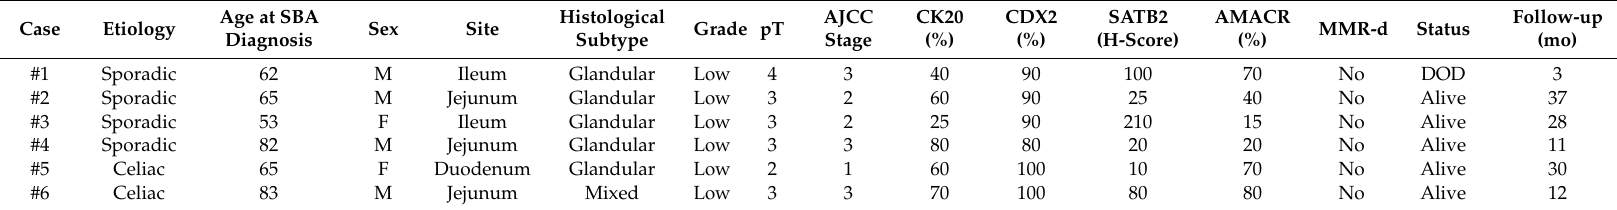
Clinico-pathologic features of the six small bowel adenocarcinoma (SBA) cases showing a colorectal carcinoma-like